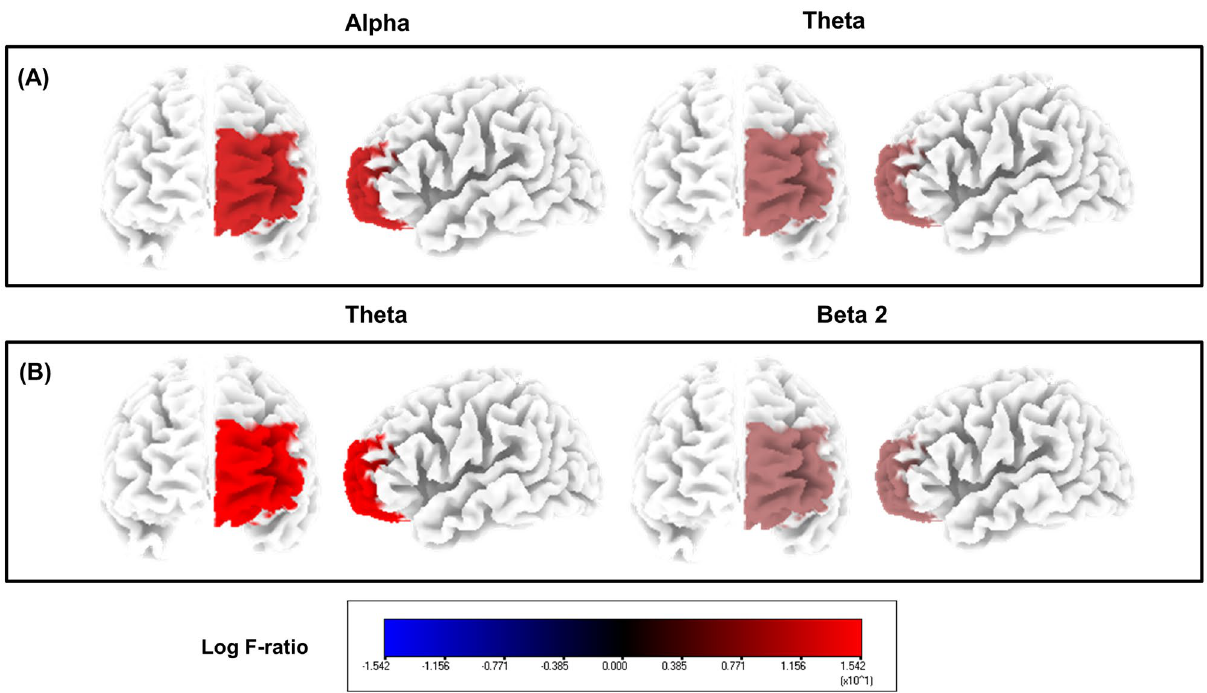
Figure 6. Source-localized cortical power differences in the prefrontal cortex. Increased power levels in the alpha and theta frequency bands ( A ) and theta and beta 2 frequency bands ( B ) after virtual reality (VR) tinnitus